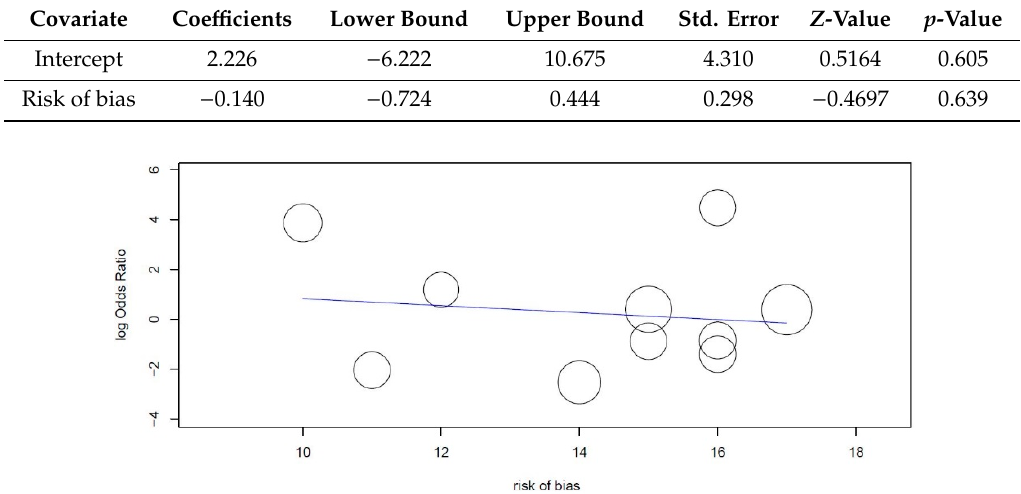
Figure 9. Meta-regression plot; it can be seen that the log odds ratio decreases when the risk of bias decreases, with a regression coefficient equal to − 0.140 per score of risk of bias points, and with a p value of 0.639.